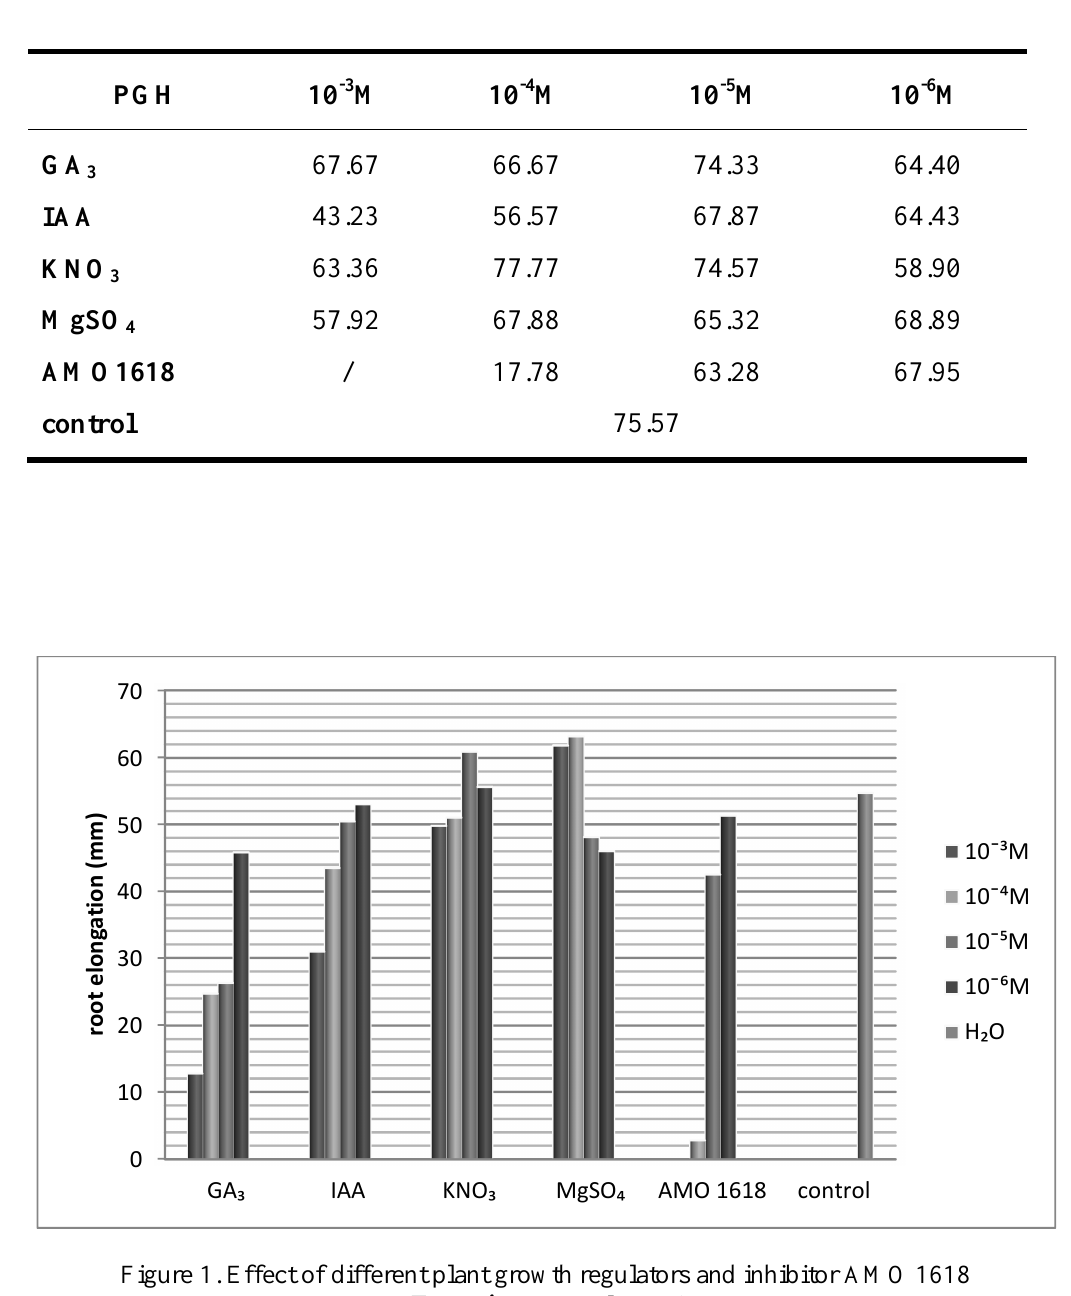
Table 2. Percent of germinated seeds of Triticosecale in different concentrations of plant growth regulators and the inhibitor AMO 1618.